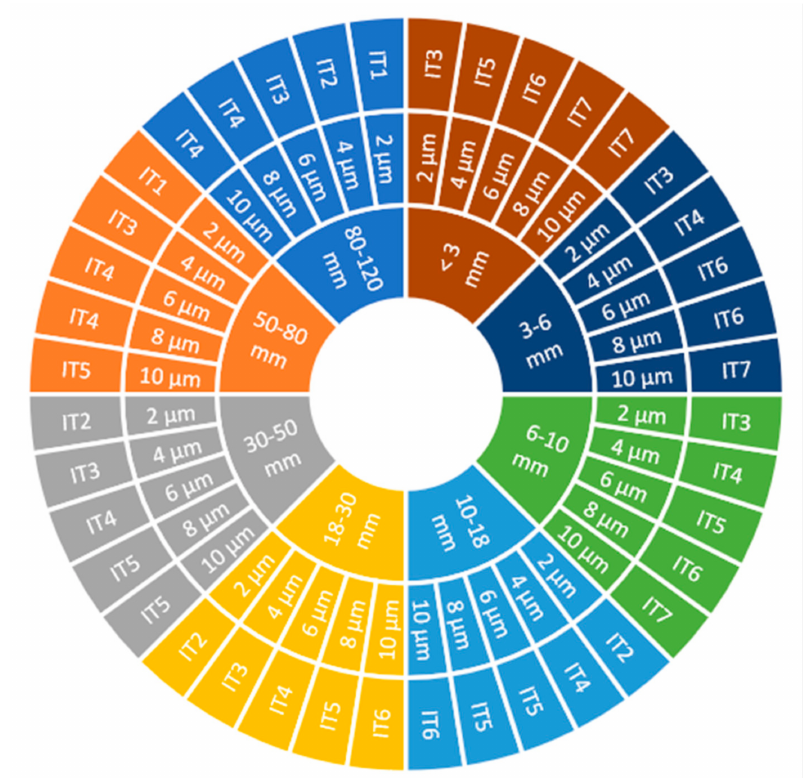
Figure 8. Standard tolerance classes IT for the tolerance of 2 µ m, 4 µ m, 6 µ m, 8 µ m and 10 µ m, depending on the nominal dimension ranging 1–120 mm.